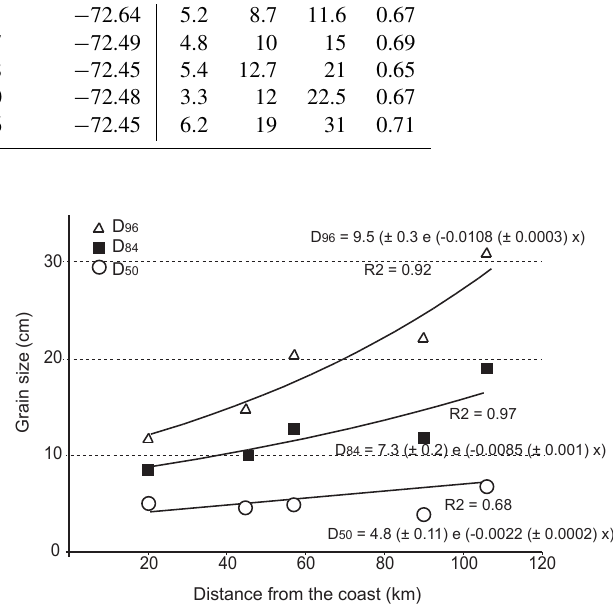
Figure 4. Grain size results along the Majes